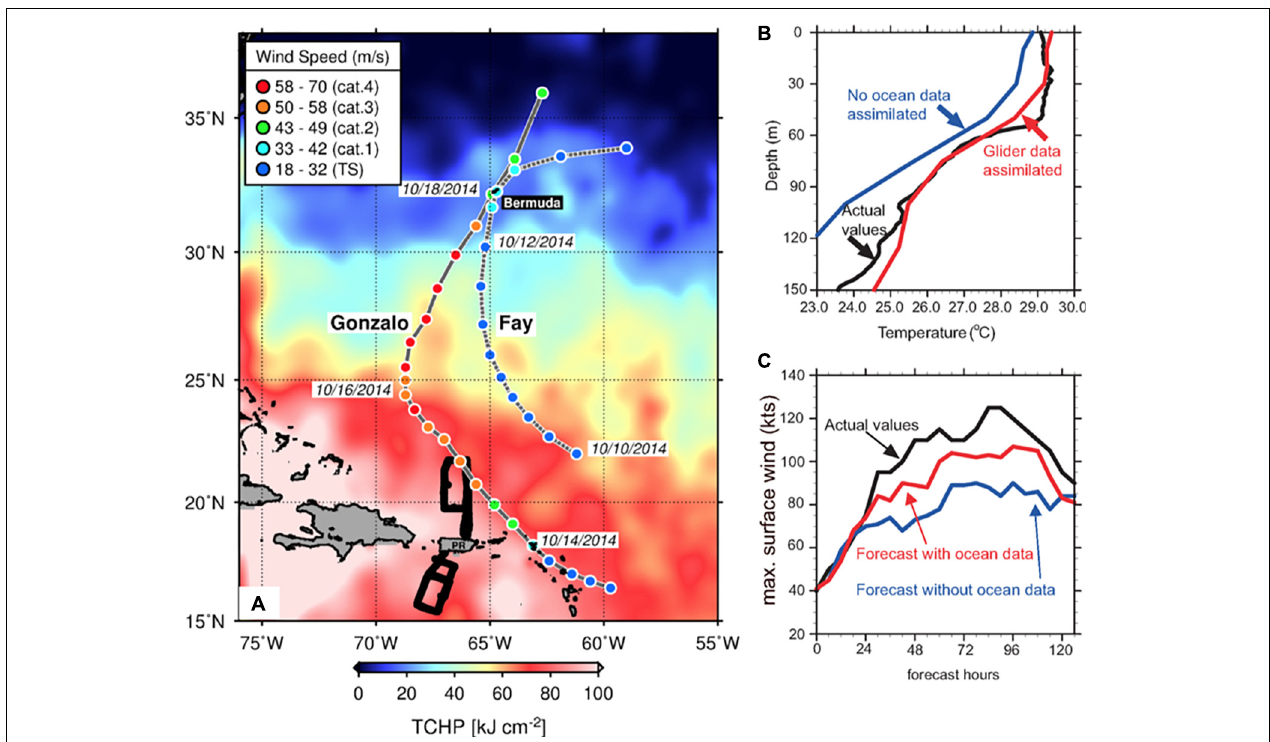
FIGURE 6 | (A) Tracks of Hurricanes Gonzalo (2014) and Fay (2014) superimposed on the altimetry-derived tropical cyclone heat potential (TCHP) during October 2014. (B) Impact of glider temperature profiles on the initialization of HYCOM-HWRF. (C) Impact of glider and other ocean data to reduce errors in TC intensity (maximum wind speed) during the forecast of Gonzalo tested on October 13, 2014. Figure adapted from Goni et al.